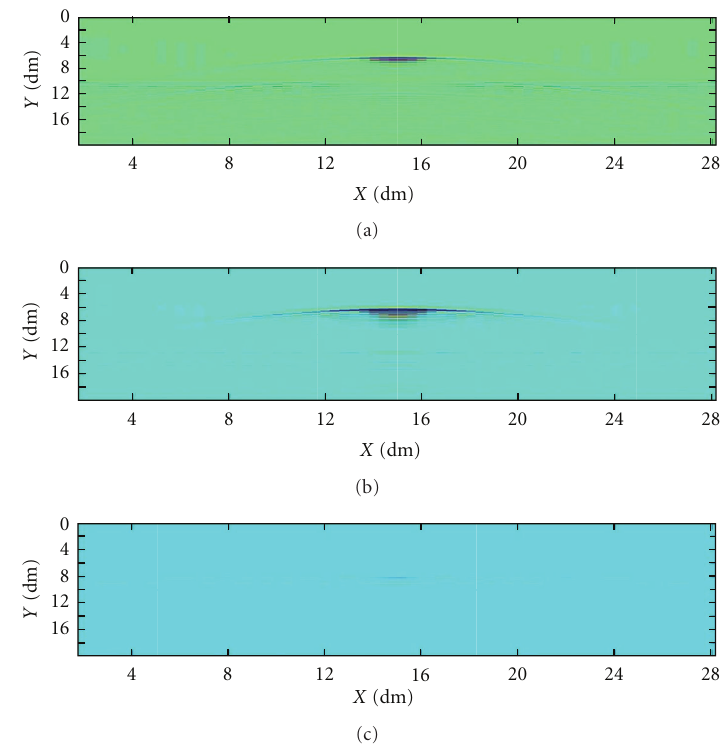
Figure 3: Windowed signal for three di ff erent values of (cid:8) M . (a) (cid:8) M = 36, (b) (cid:8) M = 10, (c) (cid:8) M = 4.